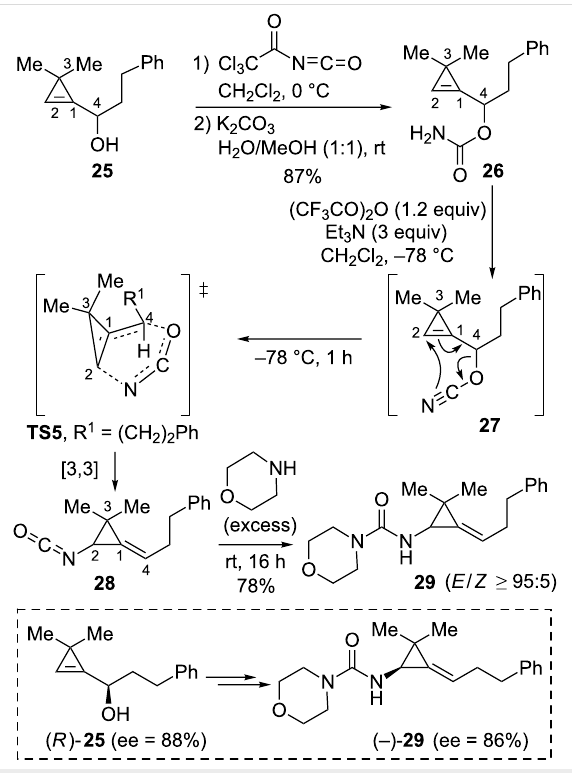
Scheme 15: [3,3]-Sigmatropic rearrangement of cyanate 27 gener- ated from cyclopropenylcarbinyl carbamate 26